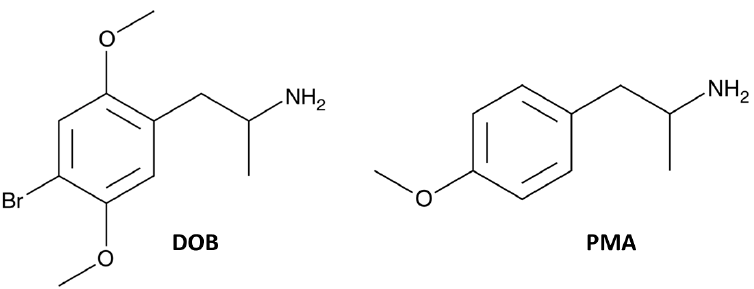
Figure 1. Chemical structures of DOB (2, 5-dimetoxy-4-bromo-amphetamine) and PMA Chemical structures of DOB (2, 5-dimetoxy-4-bromo-amphetamine) and PMA (paramethoxyamphetamine).